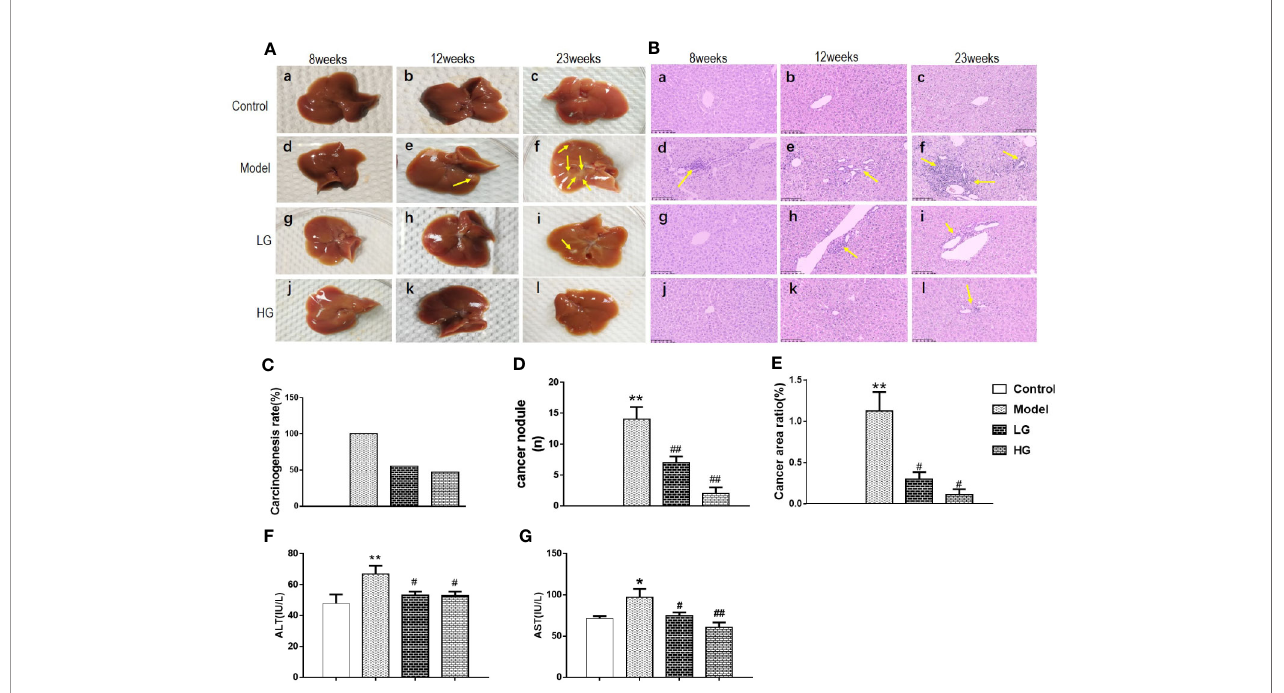
FIGURE 1 | Inhibitory effect of GHJCD on diethylnitrosamine-induced hepatocellular carcinoma in mice. (A) General appearance of the liver was changed dynamically at the 8th, 12th, and 23rd week of experiment. (B) Pathological changes in HE-stained liver sections were observed at the 8th, 12th, and 23rd week of treatment. Scale bar: 250µm. (C) Carcinogenic rate of liver cancer: the ratio of the number of mice with at least one liver cancer lesion to that of experimental mice. (D) Number of liver cancer nodules: number of liver cancer lesions in the liver. (E) Cancer area ratio: the percentage of liver cancer lesion area and liver tissue section area. (F) Serum ALT level in mice. (G) The content of serum AST in mice. *p < 0.05, **p < 0.01 vs. control; # p < 0.05, ## p < 0.01 vs.